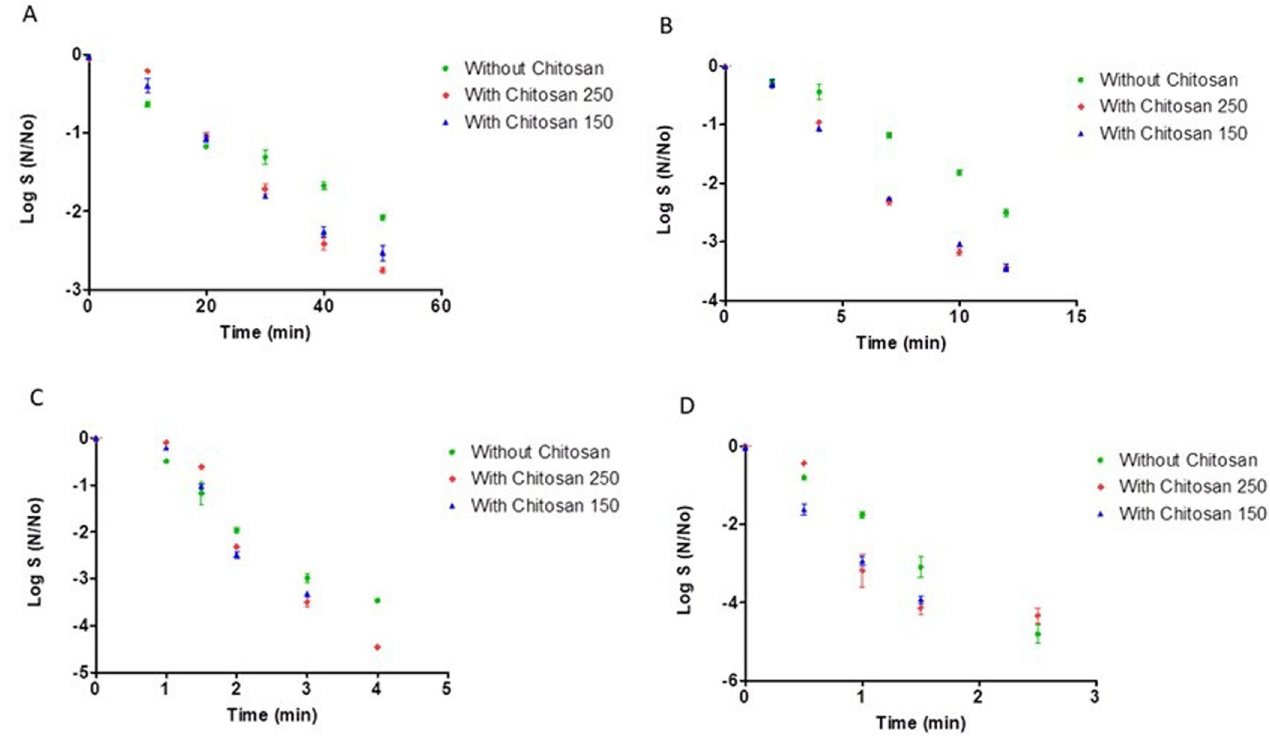
Fig 1. Survival curves for Bacillus cereus (A) heated at 90˚C, (B) heated at 95˚C, (C) heated at 100˚C, (D) heated at 105˚C.